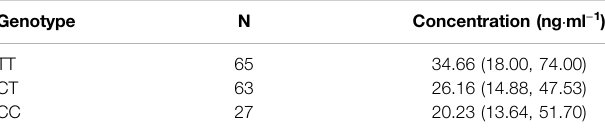
TABLE 4 | Effect of rs1128503 SNPs on rivaroxaban plasma concentrations in 155 recipients. Genotype N